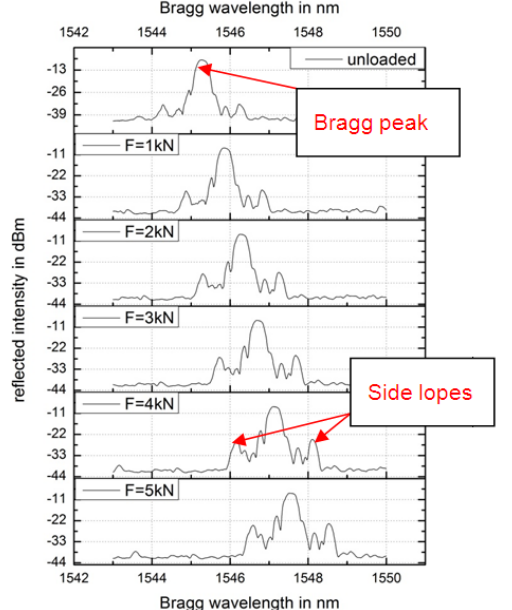
Figure 10. Reflected spectrum of the FBG patch with embedded bare fiber at different load